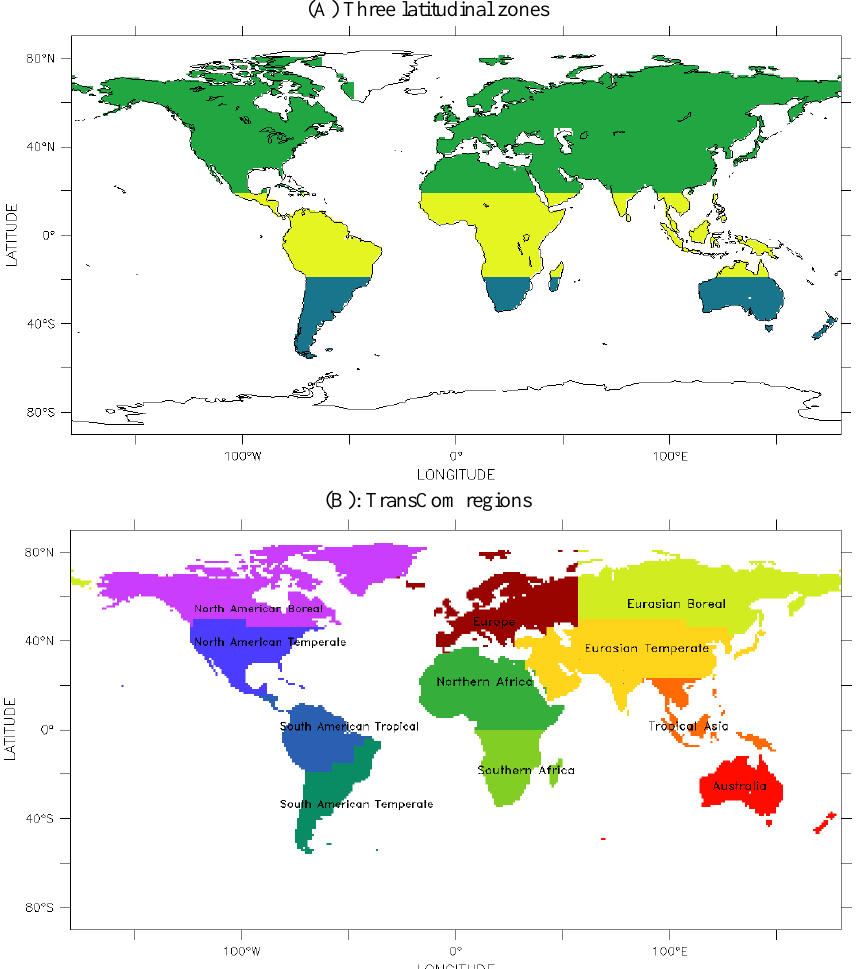
Fig. 3. Map of the land regions over which the estimated fluxes are integrated to obtain time series. (A) land regions for three latitudinal bands defined as (90 ◦ S–20 ◦ S, 20 ◦ S–20 ◦ N and 20 ◦ N–90 ◦ N). (B) land regions as defined in the TransCom3 project (Gurney et al.,